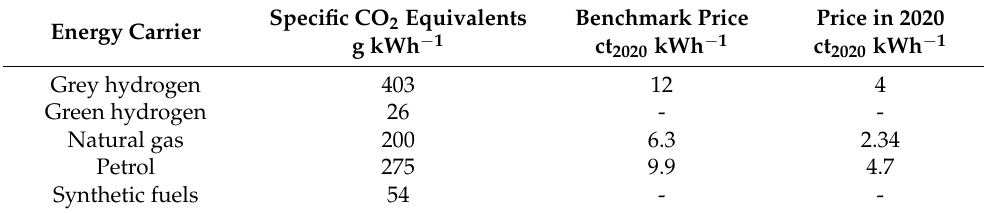
Figure 2. Expected production costs of green hydrogen and synthetic fuels up to 2050 compared to price projections for grey hydrogen, natural gas (prices for industry customers), and crude oil (dashed lines) with consideration of individual environmental impact costs based on [39]. Prices for grey hydrogen, natural gas, and crude oil in solid lines represent the actual price developments including specific environmental impact costs. Linearly interpolated data based on [7–10,24–28,30,33–37]. Table 1. Specific CO 2 equivalents of all considered energy carriers and calculated benchmark prices for conventional fuels. CO 2eq . values for green hydrogen and synthetic fuels apply for a production via water electrolysis with renewable input electricity. Values for grey hydrogen apply for a production via steam methane reformation (SMR). Values for specific CO 2 equivalents derived from [40,41].